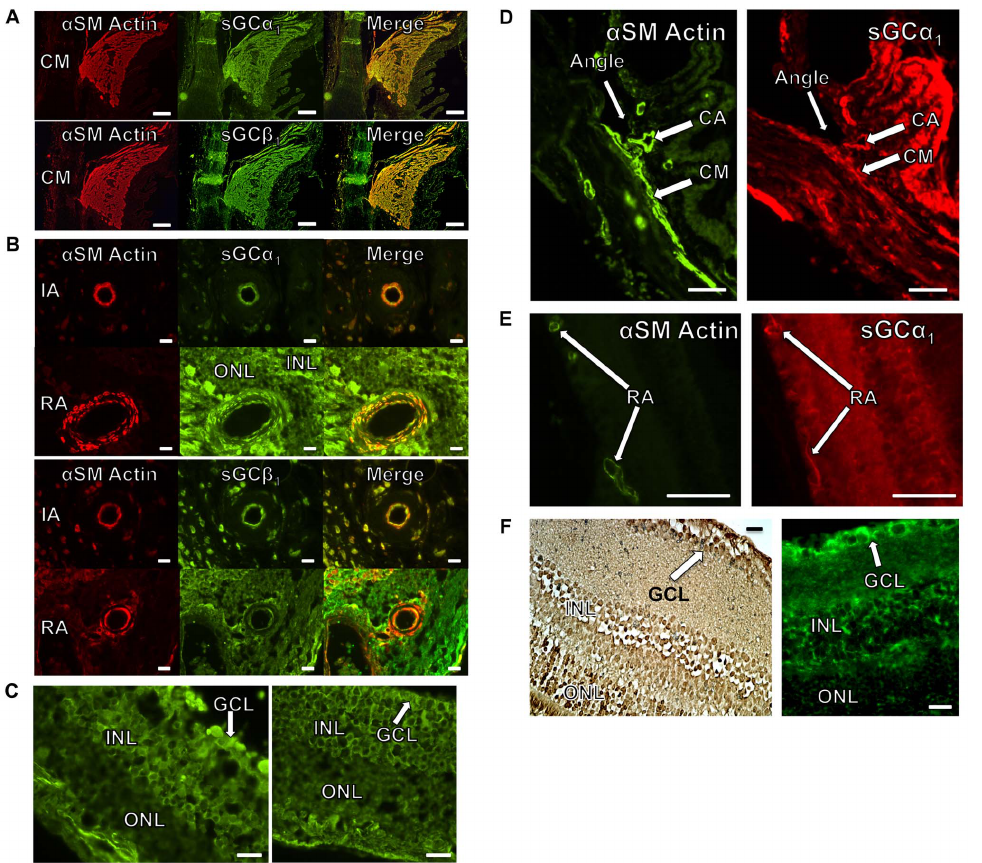
Figure 1. Localization of sGC a 1 and b 1 subunits in the human and murine eye. Panels A–C depict tissue sections from human eyes. Panels D–F depict tissue sections from mouse eyes. A : Ciliary muscle (CM), stained for a -smooth muscle actin (red), sGC a 1 (green, upper panel ), or sGC b 1 (green, lower panel ). Both sGC a 1 and sGC b 1 co-localized with a -smooth muscle actin in CM (yellow in merged images). Scale bars: 100 m m. B : An arteriole in the iris (IA) and an arteriole in the retina (RA) were stained for a -smooth muscle actin (red), sGC a 1 (green, upper panels ), or sGC b 1 (green, lower panels ). Both sGC a 1 and sGC b 1 co-localized with a -smooth muscle actin in the smooth muscle cell layer of arterioles in the iris and retina (yellow in merged images). ONL: outer nuclear layer, INL: inner nuclear layer. Scale bars: 20 m m. C : sGC a 1 ( left panel ) and sGC b 1 ( right panel ) expression was detected histologically in the outer nuclear layer (ONL), inner nuclear layer (INL), and ganglion cell layer (GCL, white arrow) of the retina. sGC a 1 and sGC b 1 are visualized by green fluorescence. Scale bars: 20 m m. D : Adjacent sections of a wild-type (WT) murine eye were stained for a -smooth muscle actin (green, left panel ) or sGC a 1 (red, right panel ). sGC a 1 co-localized with a -smooth muscle actin in ciliary muscle (CM) and in arterioles in the ciliary body (CA). The iridocorneal angle is indicated. Scale bars: 50 m m. E : Adjacent sections of a WT murine eye were stained for a - smooth muscle actin (green, left panel ) or sGC a 1 (red, right panel ). sGC a 1 co-localized with a -smooth muscle actin in retinal arterioles (RA). Scale bars: 50 m m. F : sGC a 1 ( left panel ) and sGC b 1 ( right panel ) expression was detected histologically in the outer nuclear layer (ONL), inner nuclear layer (INL), and ganglion cell layer (GCL, white arrow) of the mouse retina. sGC a 1 is visualized by brown peroxidase stain and sGC b 1 is visualized by green fluorescence. Scale bars: 20 m m.